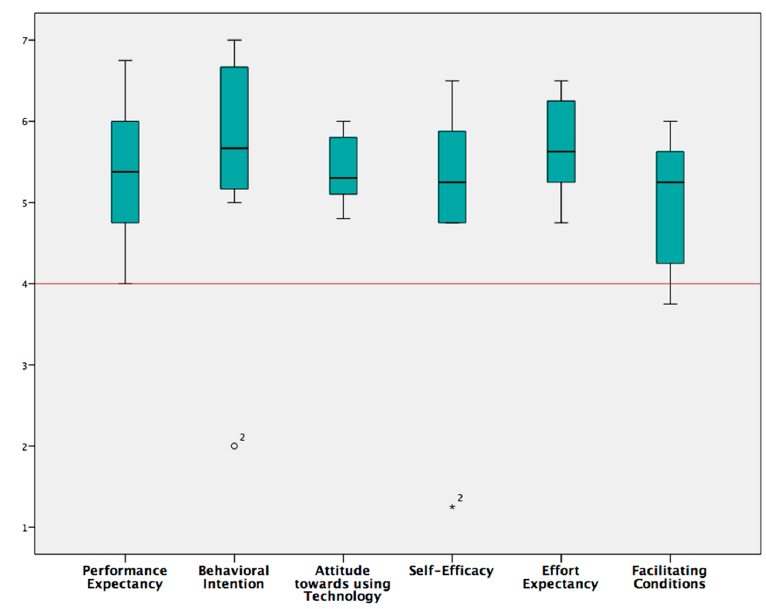
Figure 13. Technology acceptance was measured with the UTAUT questionnaire, achieving positive evaluations by the participants.